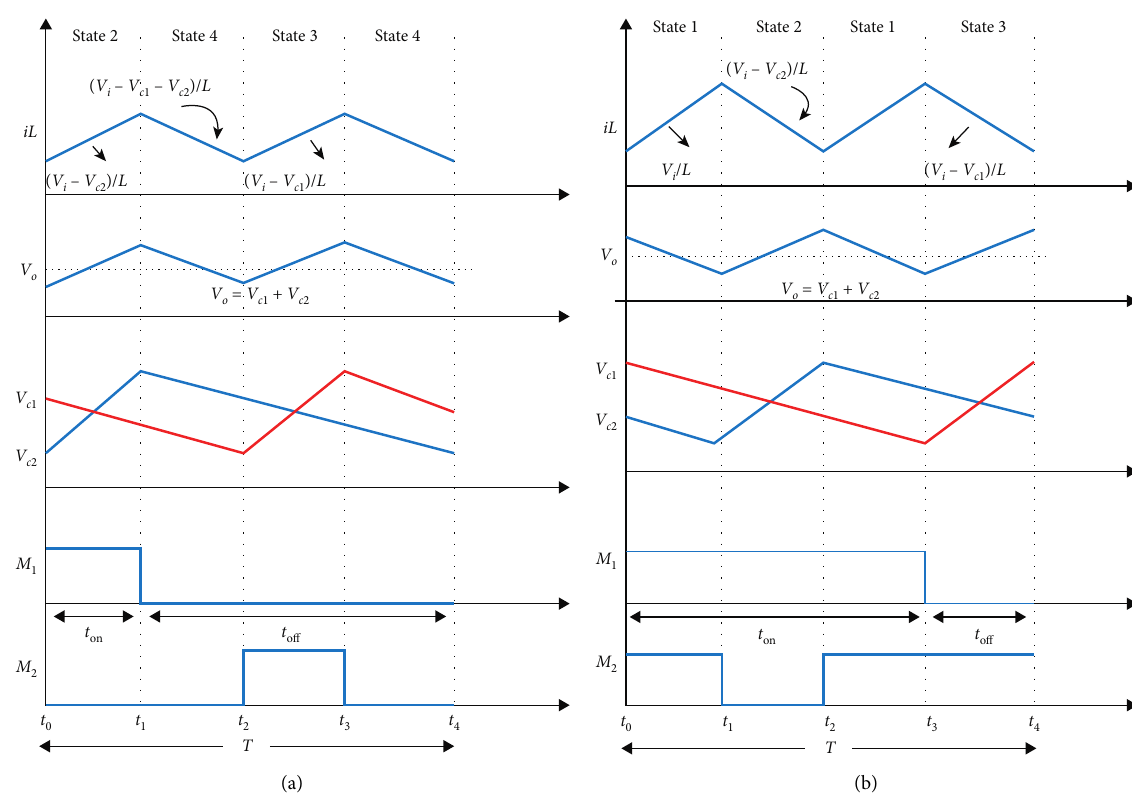
Figure 4: Typical waveforms of the TLBC, including the inductor current, the output voltage, the capacitor voltages, and the control signal of the switches for the case of (a) V i ≥ 1/2 V o and (b) V i < 1/2 V o